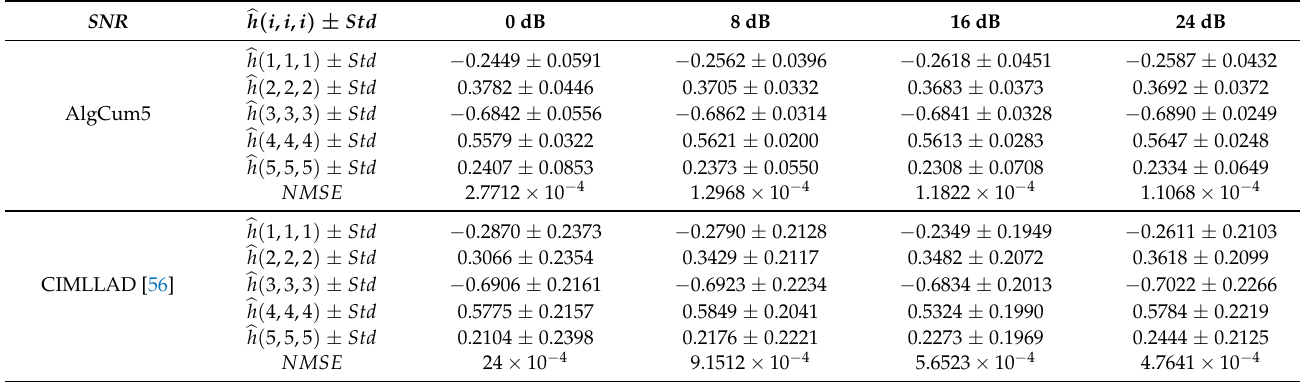
Table 3. True and estimated (means ± Std. Dev.) cubic kernels of system II.